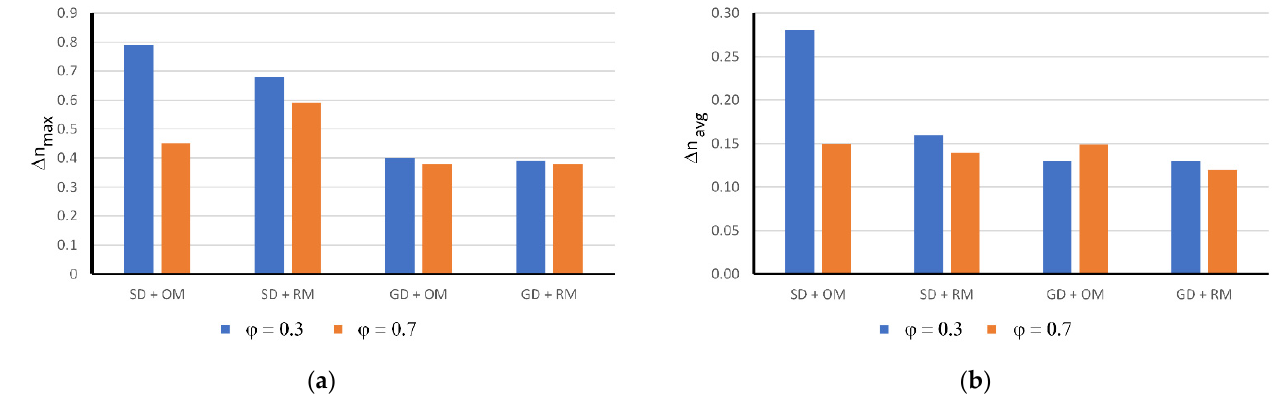
Figure 14. List of maximum values ( a ) and average ( b ) relative differences in the rotational speed of the road wheels during the simulation when the vehicle model was driven through the ditch at different maximum values of the adhesion coefficient: GD—gear-type flow divider, SD—spool-type flow divider, OM—orbital motor, RM—radial piston motor.